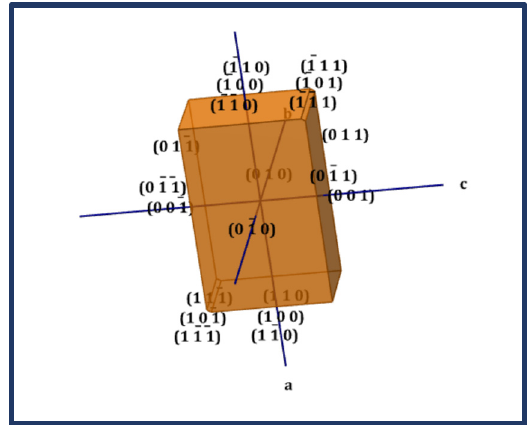
Figure 5. Morphology of MMPI